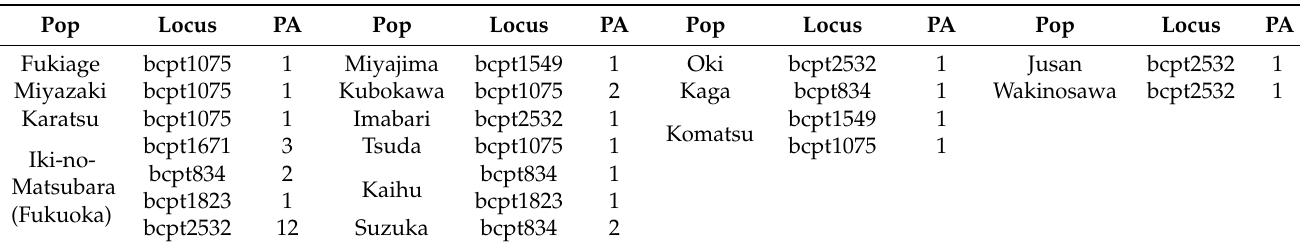
Table 3. Private alleles in Iki-no-Matsubara with 42 old populations of P. thunbergii throughout Japan using six primers. Pop Locus PA Pop